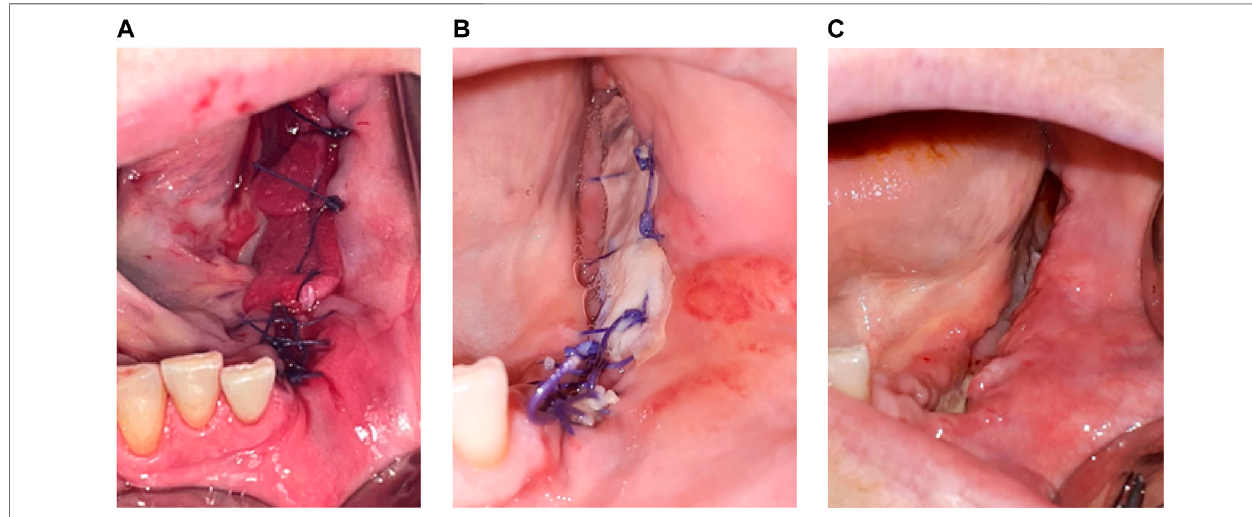
FIGURE 3 | Patient 8 (A) hAM application, sutured on a collagen sponge. (B) Three days post-surgery. (C) Ten days post-surgery, with the reepithelialization on more than of the surgical